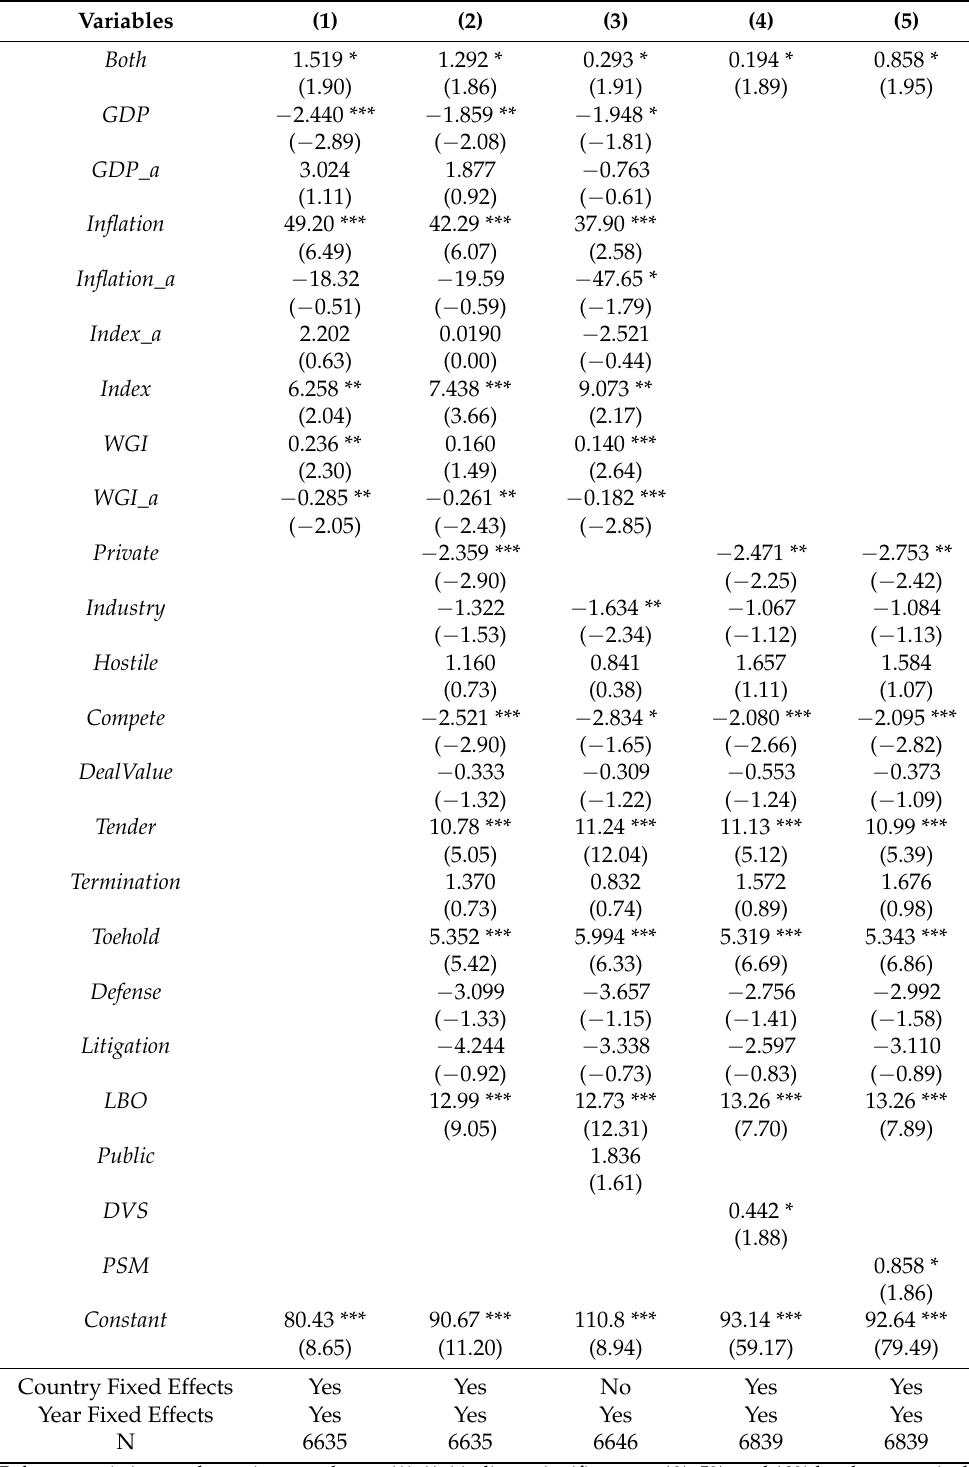
Table 12. Proportion of cash paid for cross-border deals. This table presents the results of five panel fixed-effects regressions for a subsample of cross-border M&A deals. The dependent variable is CashPaid , the percentage of cash included in the payment for the M&A transaction. The main independent variable is Both , an indicator variable that equals 1 if social media is popular in both the acquirer and target countries. In addition to the control variables described previously, macro- economic variables for the acquiring country are included. Standard errors are double clustered by country and